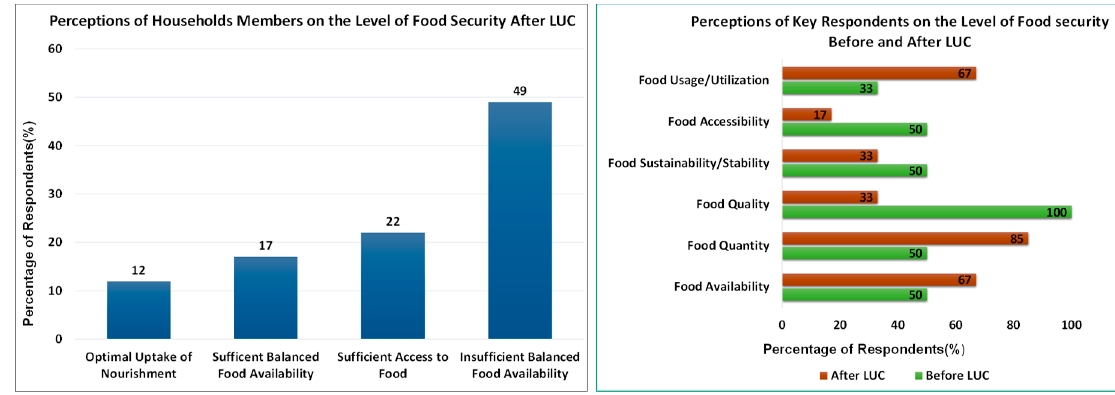
Figure 5. Scenarios of food security in Nyange Sector.